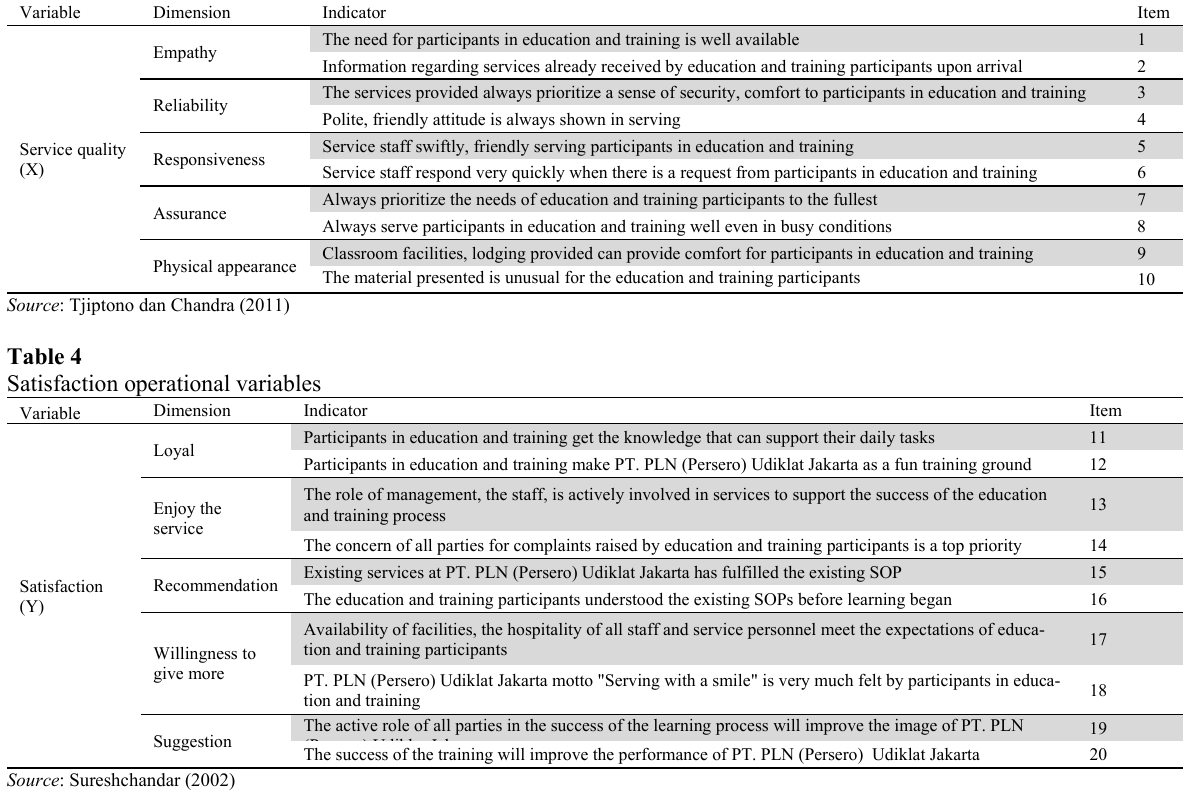
Service quality operational variables